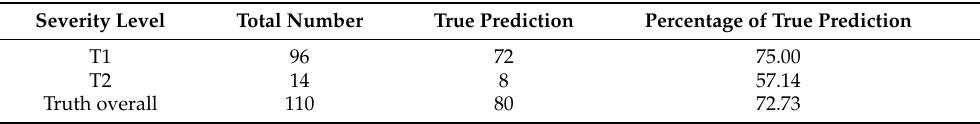
Table 6. The producer accuracy for ANN testing model for T1 and T2 severity level. The overall accuracy is 72.73%, and Kappa is